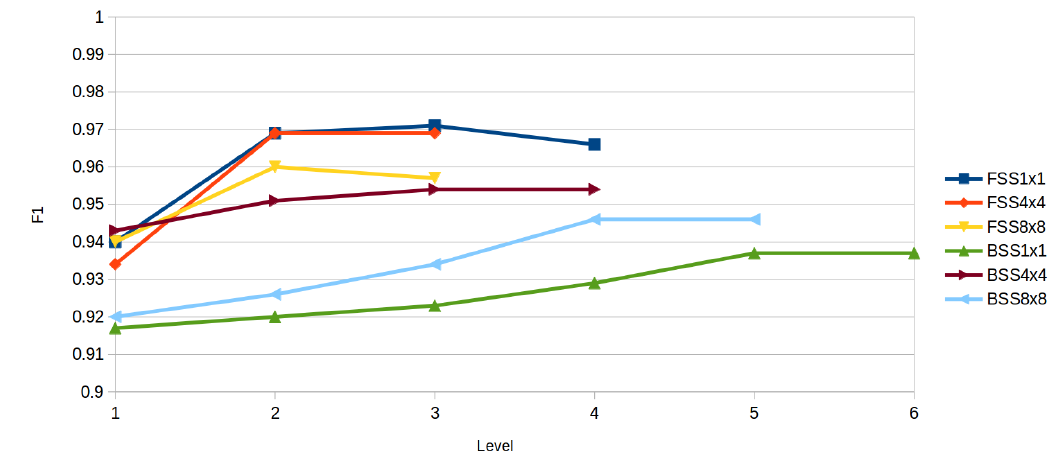
Figure 7. Comparative of highest F1 of each iteration of the Subset Selection techniques. FSS stands for Forward Subset Selection and BSS stands for Backward Subset Selection. The numbers after each selection technique stand for the number of windows the descriptor has been applied